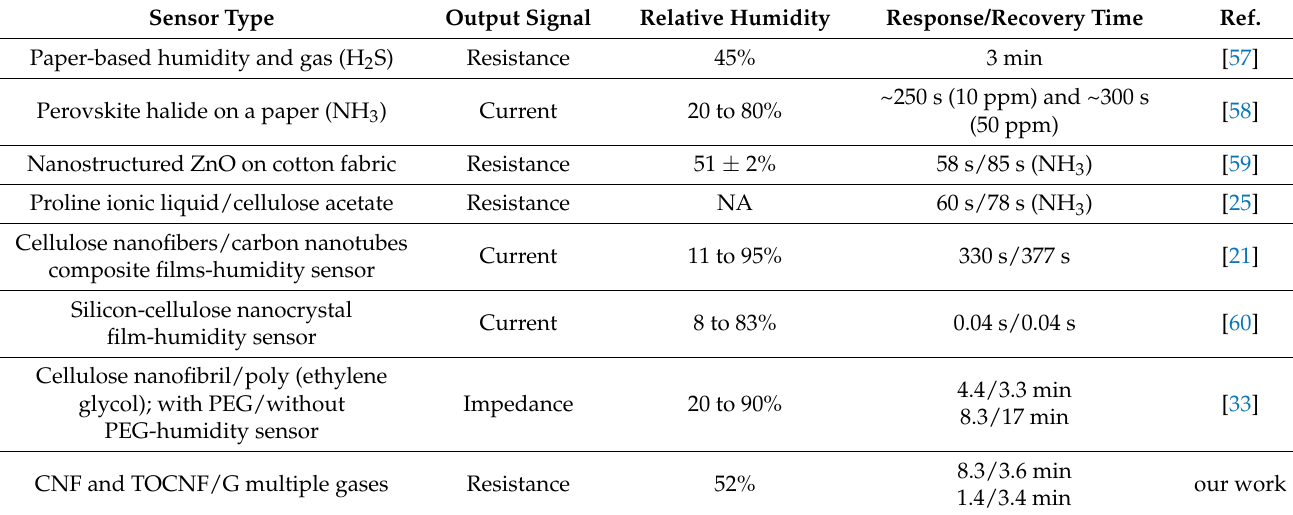
Table 2. Comparison of the gas/humidity sensors performance between this work and previous